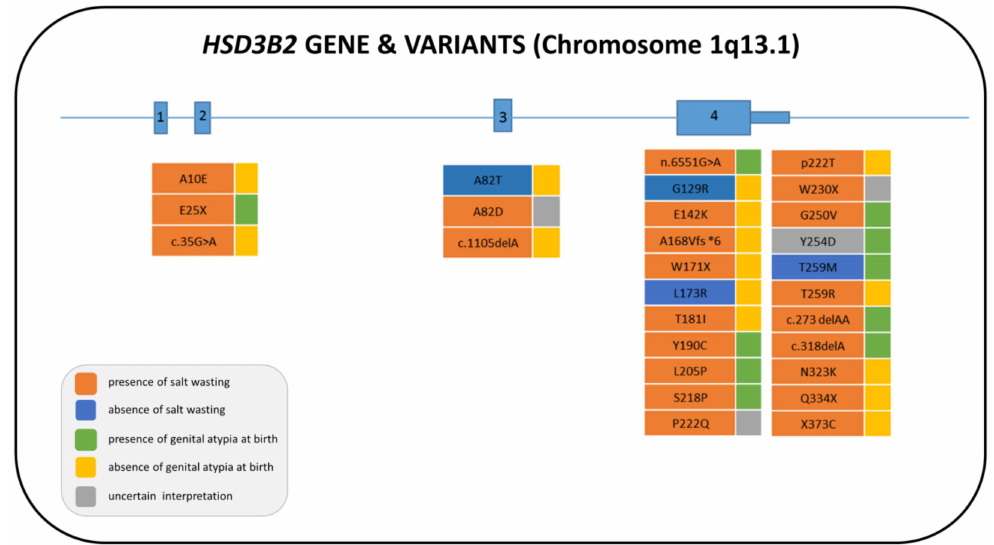
Figure 2. Structure of the human HSD3B2 gene with the pathogenic variants described in 46,XX. The nomenclature and the color of the boxes of each pathogenic variant are in accordance with the phenotypic characteristics described in each patient, the variant present on the second allele and the references cited in Table